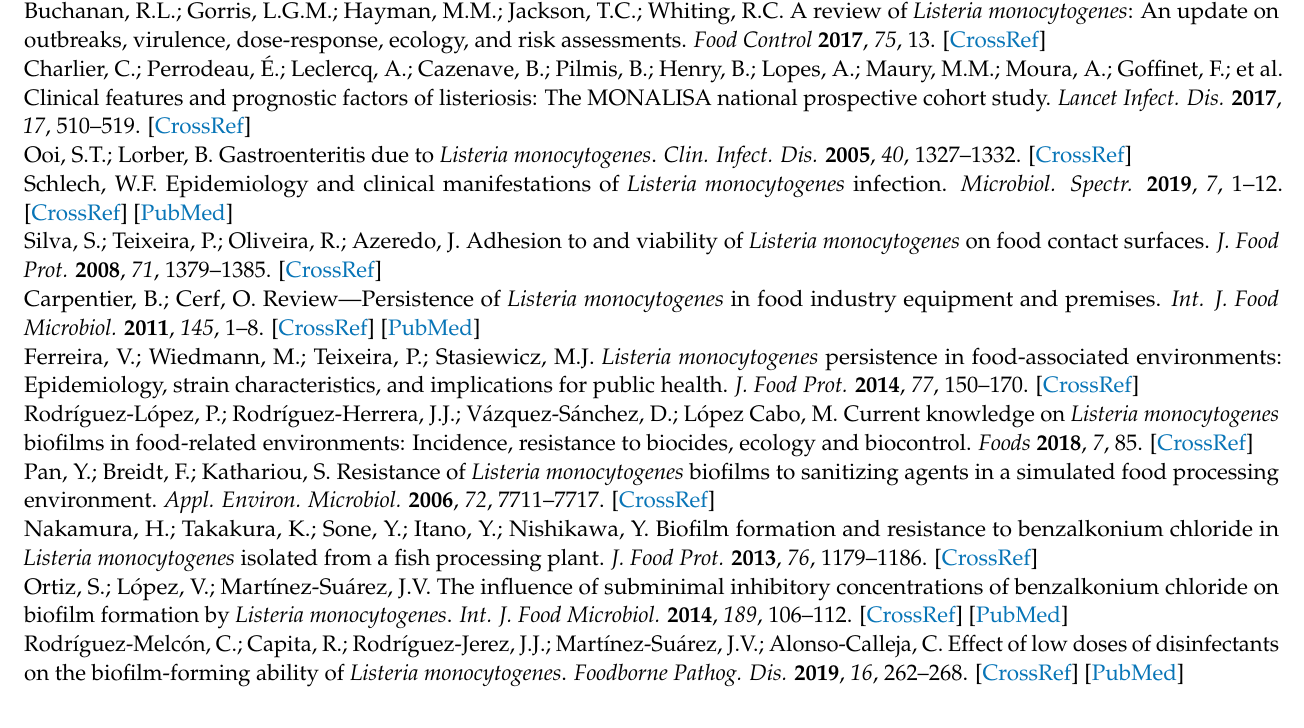
Table S1: Results of microbiological analysis of foods samples. Table S2: Checklist applied in audits. Table S3: Results of microbiological surface analysis. Table S4: Genome data information. Table S5: SNP distance matrix for L. monocytogenes genomes of serogroups IVb and